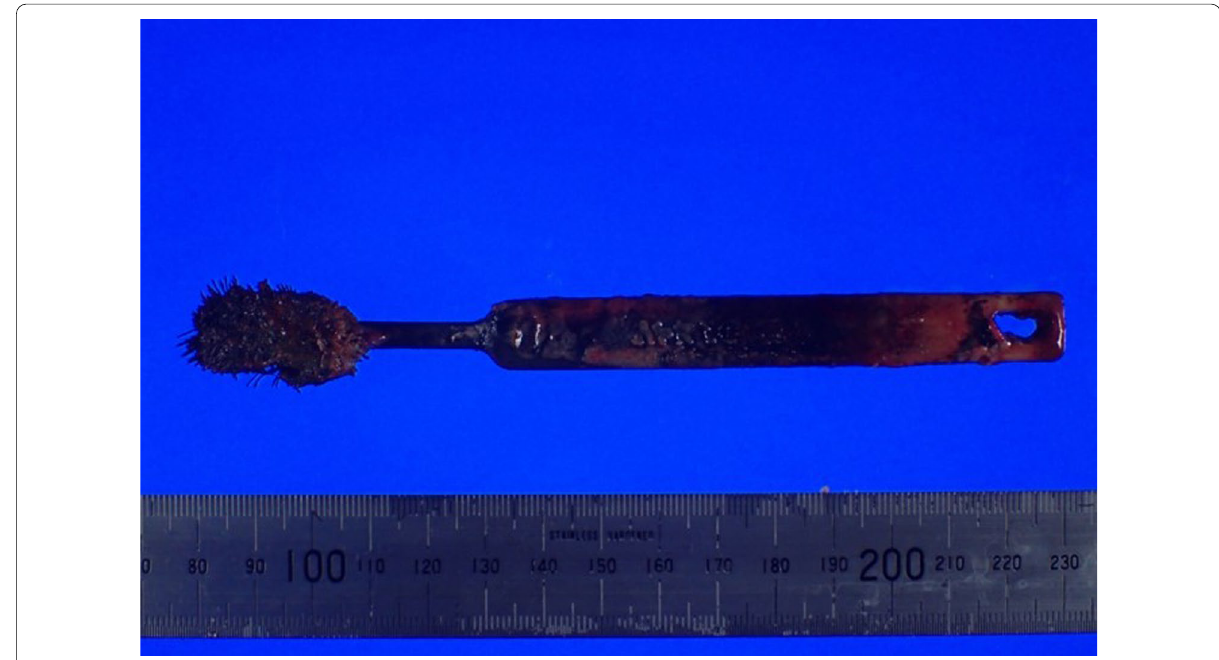
Fig. 4 The extracted toothbrush was 15 cm in